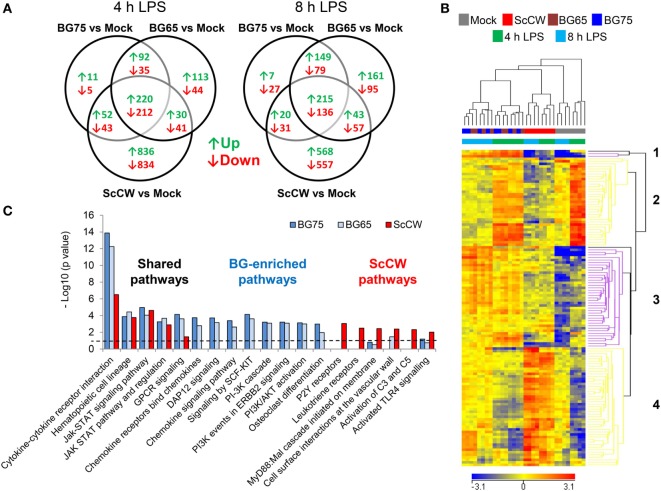
Gene expression profiling reveals specific hallmarks of β-glucan (BG)-pretreated macrophages after lipopolysaccharide (LPS) exposure. Wild-type bone marrow-derived macrophages (BMDM) were cultured in 24-well plates and treated with 100 µg/mL of the set of three BG extracts for 8 h in triplicate. After incubation, supernatants were removed and cells were stimulated with 100 ng/mL of ultraPure LPS for 4 or 8 h. A microarray analysis was performed using Agilent mRNA transcriptomic analysis. After quality control and normalization, data were analyzed using Agilent GeneSpring GX software by two-way ANOVA and Benjamini–Hochberg post hoc correction. Transcripts with a p-value of less than or equal to 0.001 and a fold change (FC) value of at least 1.5 between conditions in at least one sample were selected for further analysis. (A) Venn diagrams showing the overlap of upregulated (↑) and downregulated (↓) genes in each condition were obtained using VENNY 2.0. (B) Unsupervised hierarchical clustering (Euclidian distance) of transcriptional profiles, displayed as a heatmap of FC expression values, from BG-treated BMDM compared to non-treated BMDM upon LPS exposure. Each row represents a transcript and each column an individual sample. The heatmap shows 4 clusters constituted by entities with a p-value of 0.001 for which FC were greater than 5 compared to mock plus 8 h LPS-stimulated cells. Red indicates over-expressed and blue indicated under-expressed transcripts. (C) Based on a comparison of FC expression values between BG pretreatments and the non-pretreated condition upon 8 h of LPS exposure obtained from GeneSpring software (FC >1.5), we performed a pathway over-representation analysis using Innate DB. Significant pathways which p-values (calculated by the hypergeometric algorithm) were lower than 0.05 are displayed for each BG pretreatment condition (threshold value–log p-value = 1.30).